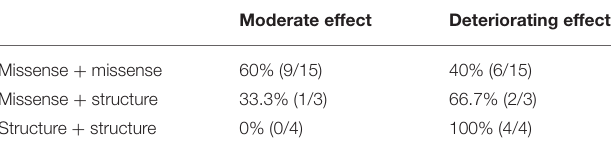
TABLE 2 | Phenotype related to variant